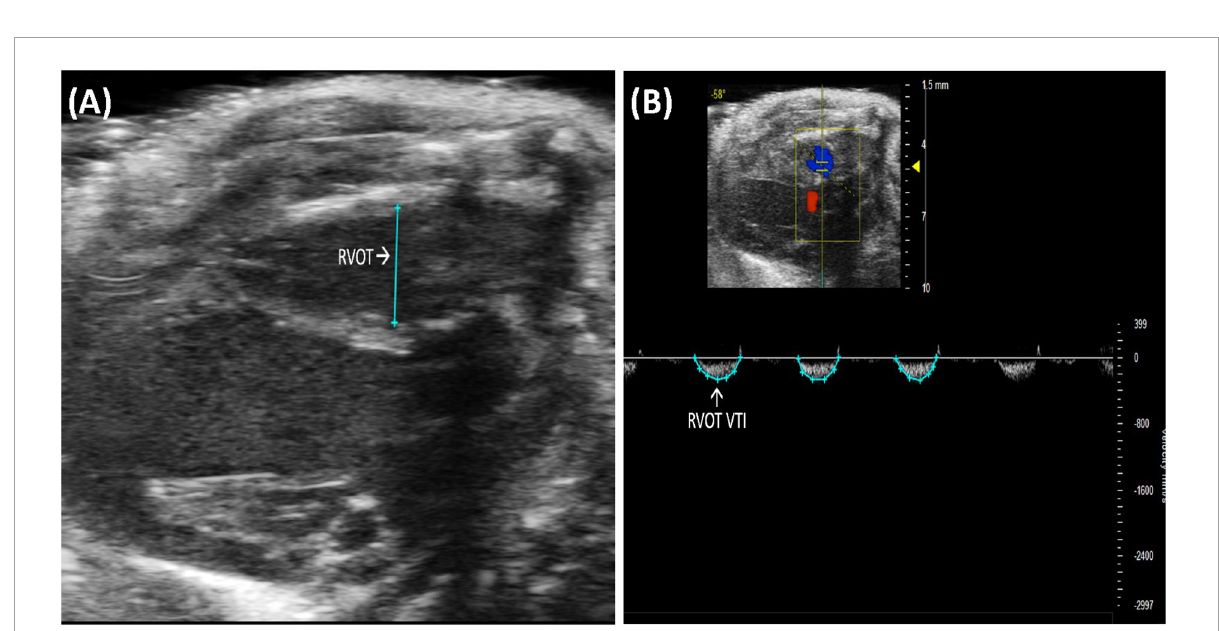
FIGURE3 (A) Right ventricular outflow tract (RVOT) measures the size of the right ventricular outflow tract at the end of diastole and is acquired and analyzed in B-mode of the parasternal long axis (PLAX) view. (B) Right ventricular outflow tract velocity time integral (RVOT VTI) measures blood flow through the right ventricular outflow tract (RVOT) and is acquired by pulsed wave (PW) Doppler imaging of the RVOT in B-mode of the parasternal long axis (PLAX) view.